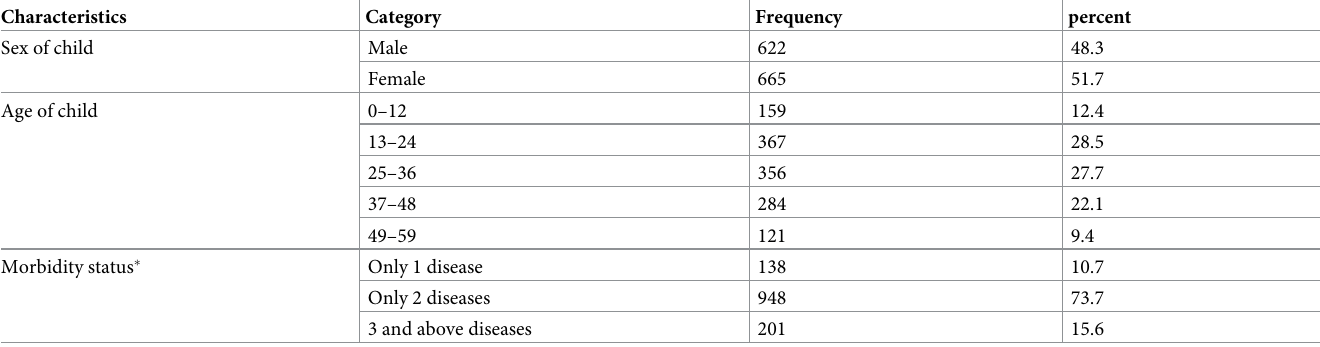
Table 2. Children health and characteristics at Libo-kemekem district, northwest Ethiopia.